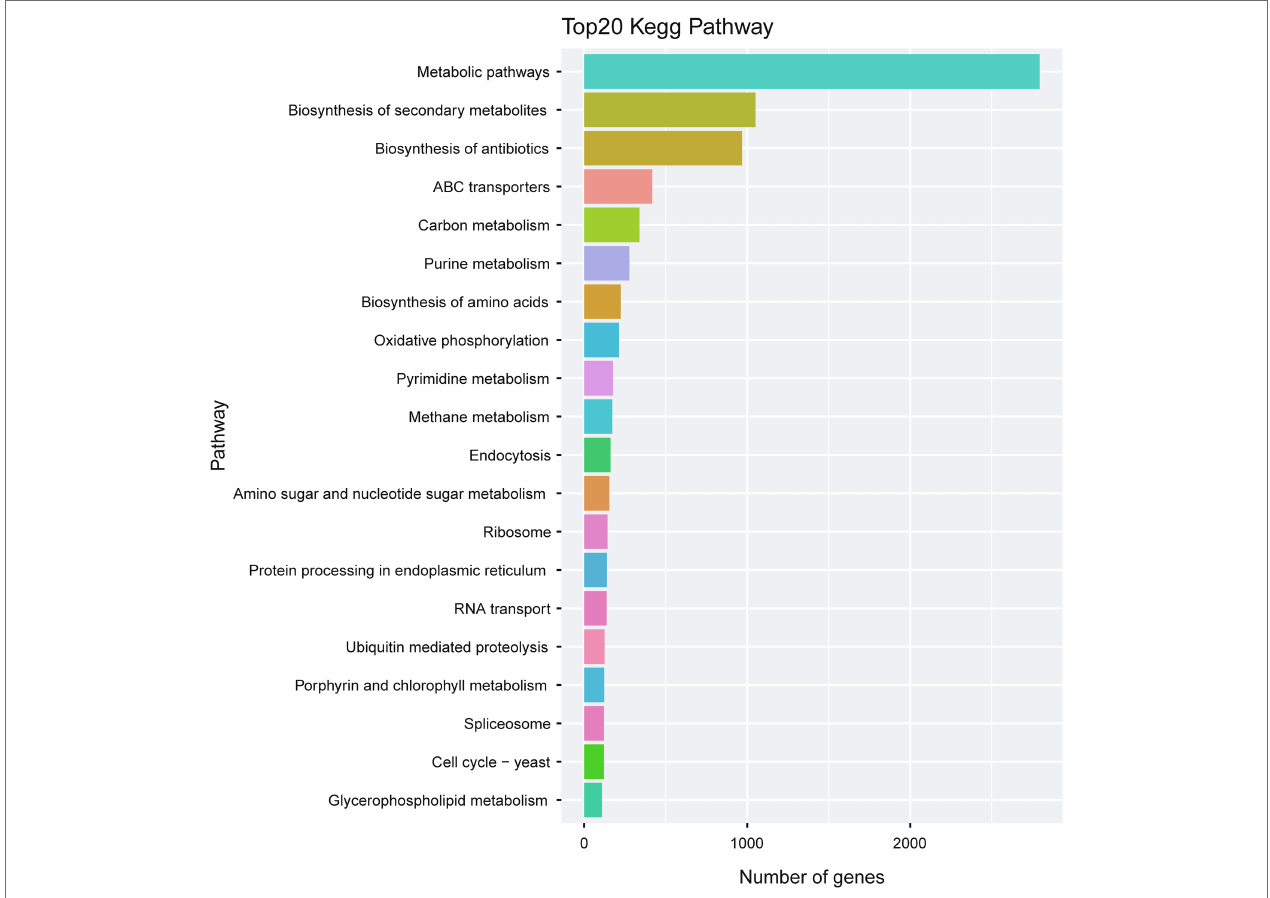
FIGURE 8 | Kegg pathway analysis of the predicted genes in A. alternata (Y784-BC03). The Kegg bar chart indicates the top 20 pathways exhibiting gene enrichment, the horizontal axis is the number of genes, and the vertical axis is the